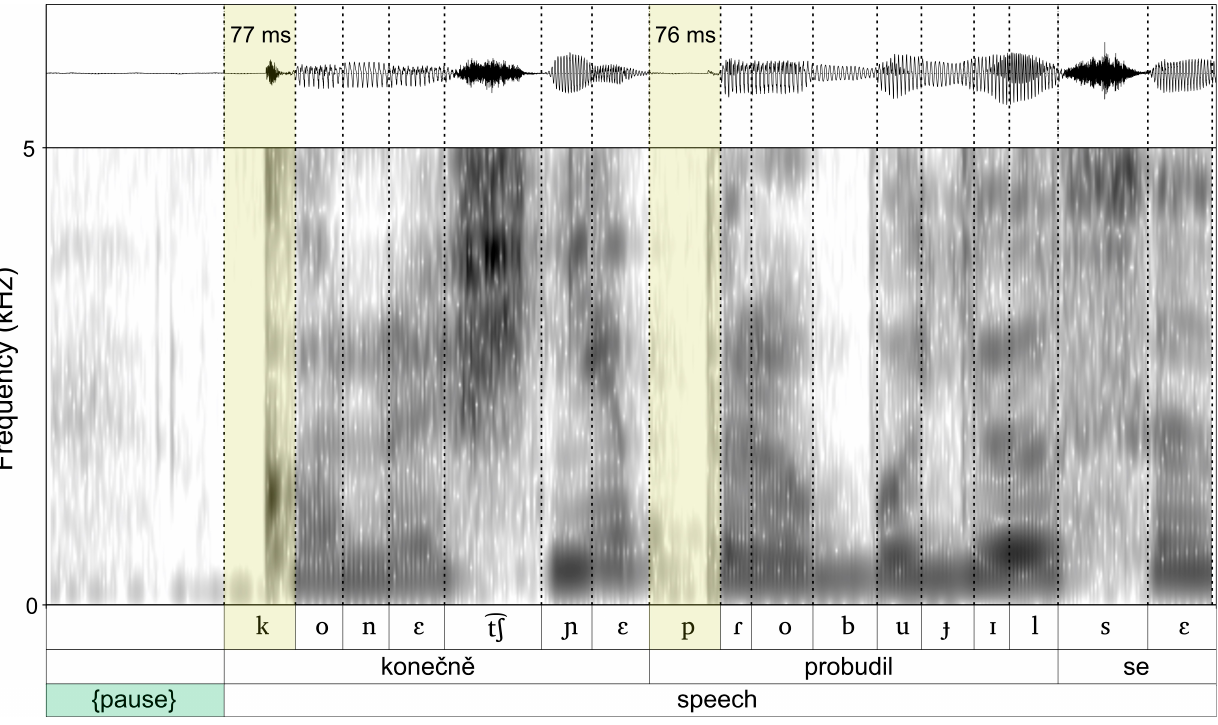
Figure 1. Segmentation of word-initial plosives. Their duration is annotated below a threshold (see text) and any remaining ‘silence’ (which may be filled with acoustic signal) is annotated as a pause.